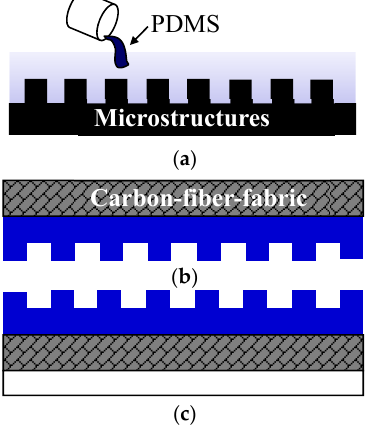
Figure 6. Fabrication of Microstructure Composite Belt by Coated Casting Technology. ( a ) casting PDMS; ( b ) insert carbon fiber fabric; ( c ) microstructure composite belt after integration and solidification.